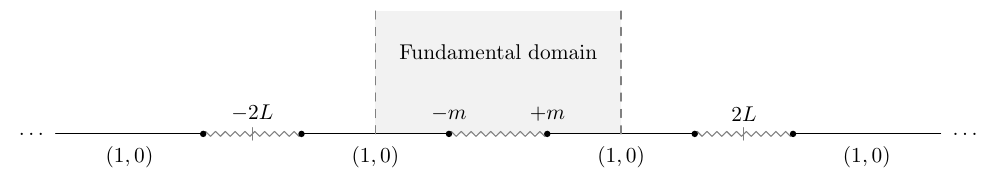
Figure 1 . Rod structure for Example 1. Here, as in future rod diagrams, the z -axis is drawn horizontally and the zigzag lines indicate horizon rods. The z -coordinates of the end points of the horizon rod in the fundamental domain are indicated above the z -axis, while the rod structures of the axis rods are indicated